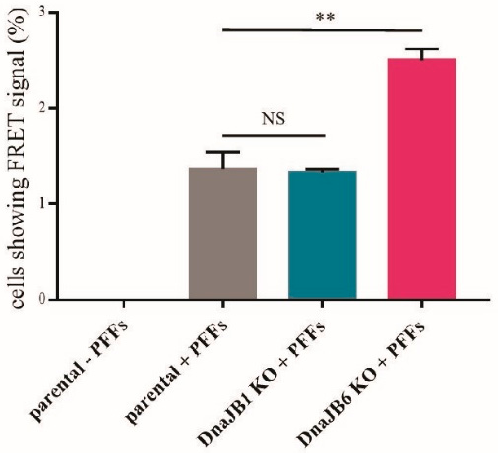
Figure 3. The α -Syn PFF-induced aggregation of α -Syn following the KO of DNAJB1 or DNAJB6 in the α -Syn CFP / YFP HEK293 cells analyzed by fluorescence resonance energy transfer (FRET). The quantification of the percentage of alive and single α -Syn CFP / YFP HEK293 cells producing a FRET signal, as detected by BD LSRFortessa ™ . The cells had been transfected with 10 nM of α -Syn PFFs for 48 h, ahead of the experiment. The data were analyzed by the Student’s t -test, and are represented as mean ± SD: ns p > 0.05 * p < 0.05; ** p < 0.01 ( n = 3; 0.00; 1.37 ± 0.176; 1.33 ± 0.0333; 2.5 ± 0.115).